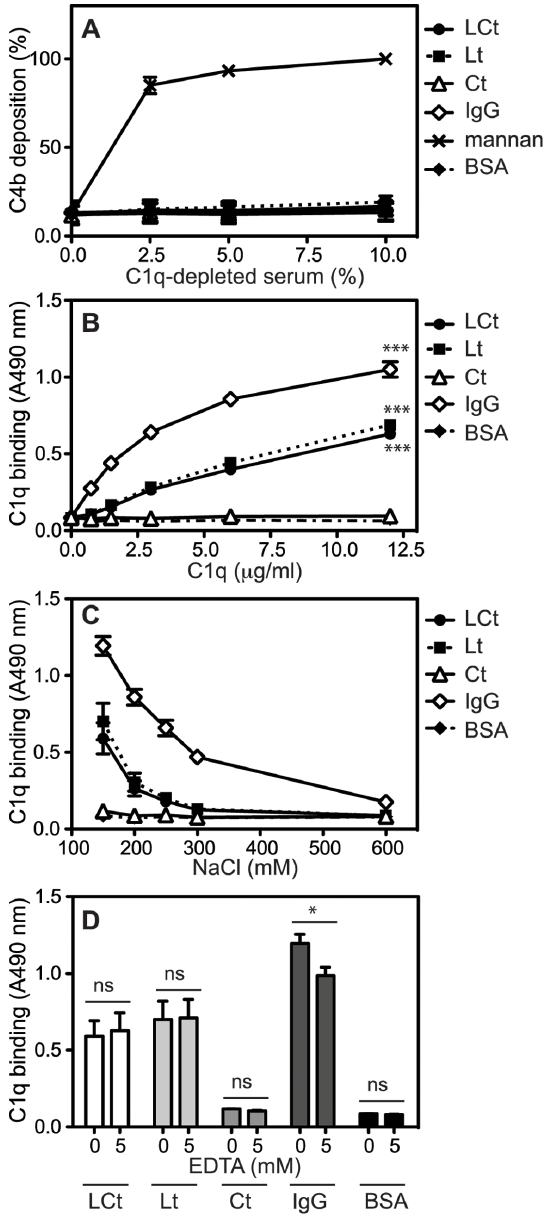
Figure 3. Lectin domain of aggrecan G3 domain activates classical pathway due to binding of C1q. A , aggregated IgG (positive control for classical pathway), mannan (positive control for lectin pathway), LCt, Lt, Ct and BSA (negative control) were coated onto microtiter plates and increasing concentrations of C1q-depleted human serum were added. Activation of the classical pathway was measured by detecting deposited C4b. The absorbance was normalized relative to deposition on mannan from 10% C1q-depleted serum. B , aggregated IgG, LCt, Lt, Ct and BSA were coated onto microtiter plates and incubated with purified C1q, which was then detected with specific antibodies. Aggregated IgG, LCt, Lt, Ct and BSA were coated onto microtiter plates and incubated with purified C1q in a buffer supplemented with increasing NaCl concentrations ( C ) or EDTA ( D ). The graphs show the mean and SD of three independent experiments. Statistical significance of differences was calculated using two-way ANOVA with Bonferroni posttest (B, D). (*p , 0.05, **p , 0.01, ***p , 0.001.).